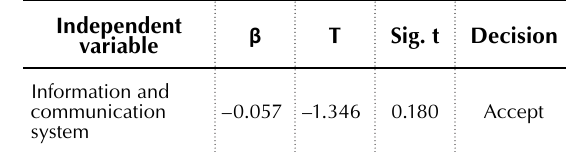
Table 7. Results of a simple linear regression analysis to test the sixth sub-hypothesis ( H06